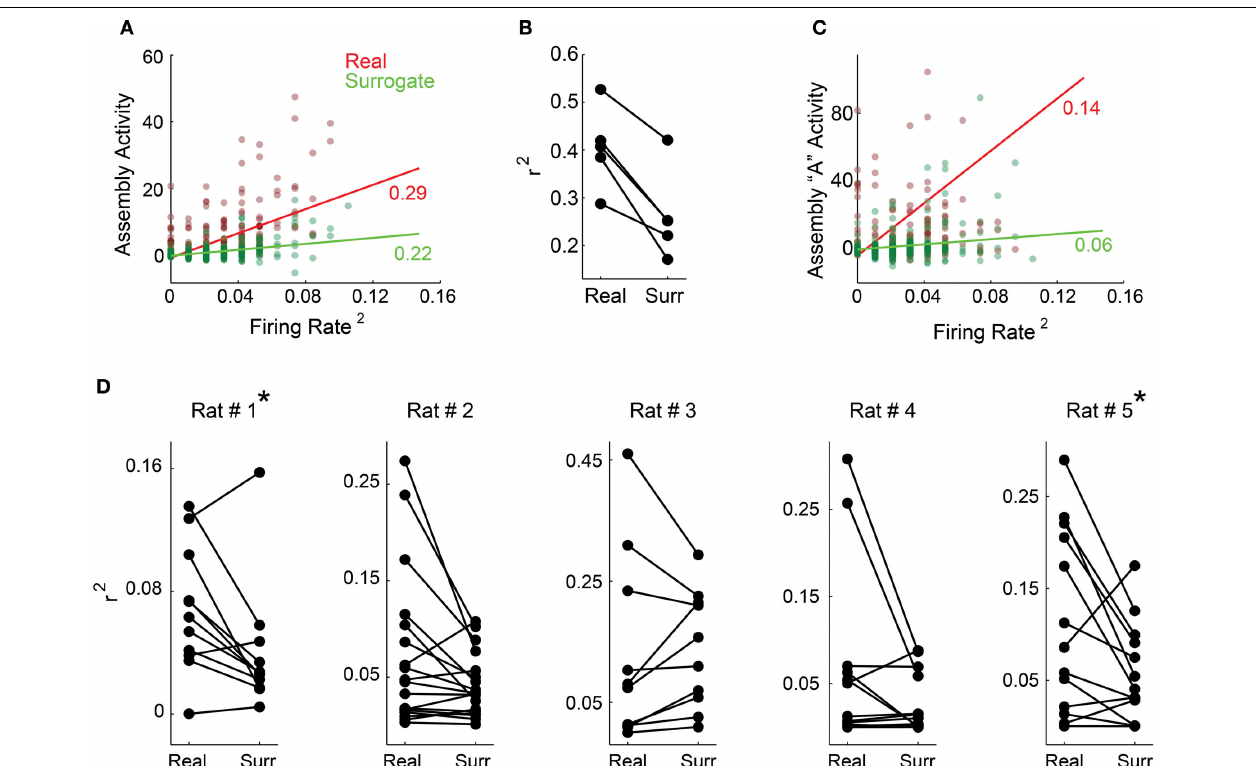
For all animals, data surrogation impaired the correlation between firing rate and assembly activity. (C) The same color code as in (A) , but plotting the mean population rate against the activity of a single exemplary assembly from rat # 1. (D) Shown are distributions of all rats R 2 values for the linear fits from the correlation between mean population rate and individual assemblies’ activity (left) and mean population rate and individual assemblies’ activity estimated from surrogated spike matrices (right). Note that both distributions exhibit very low R 2 values and that there is a decreasing trend from real to surrogated data, with significant difference for rats # 1 and # 5 ( ∗ p < 0 . 05, Wilcoxon signed-rank paired